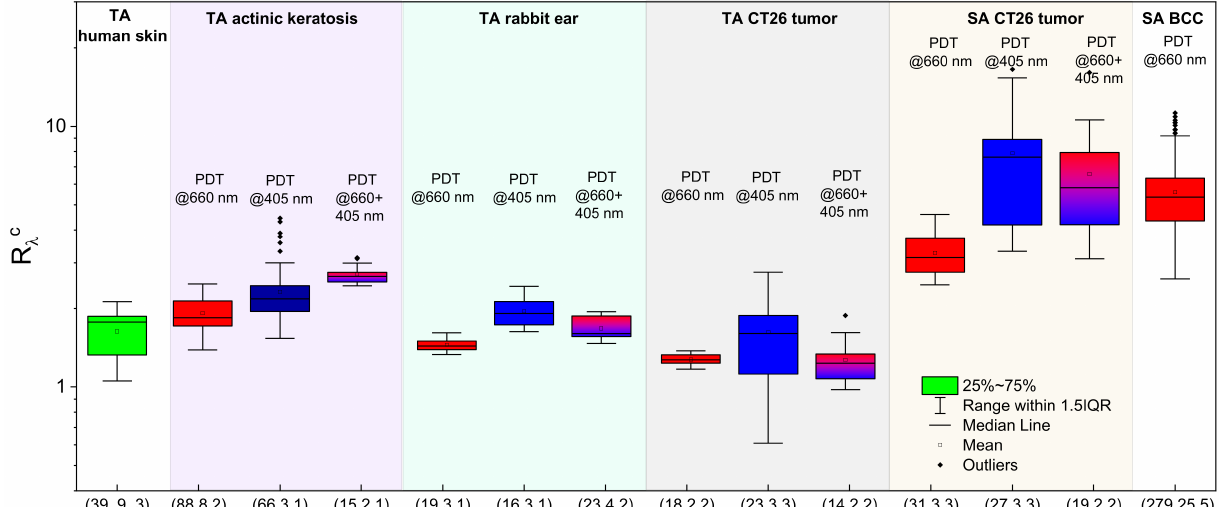
Figure 12. Normalized fluorescence signal ratio, R λ c , summarized over all of the measurements in laboratory animals, human volunteers and patients upon PS administration or/and in the course of a PDT procedure (TA—topical application; SA—systemic administration). In the brackets, total number of time points, treatment sites and independent species in the group is